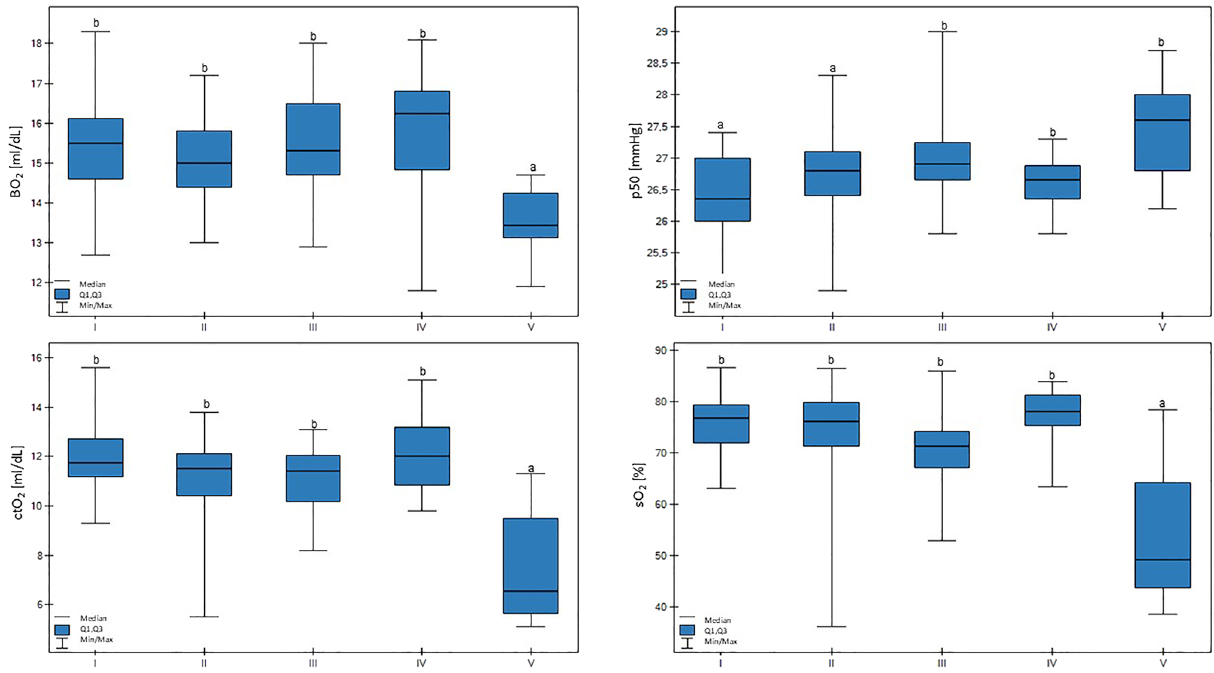
Figure 4. Differences in BO 2 (blood oxygen), p50 (hemoglobin-oxygen affinity), ctO 2 (total oxygen concentration), and sO 2 (saturation) values in cows at different production levels. In the box plots, the upper whisker represents the maximum value; the upper line of the box represents Q3 (upper quartile); the center line inside the box represents the median; the lower line of the box represents Q1 (lower quartile); and the lower whisker represents the minimum value. Groups marked by letters (a–b) differ significantly, p ≤ 0.05. The cows